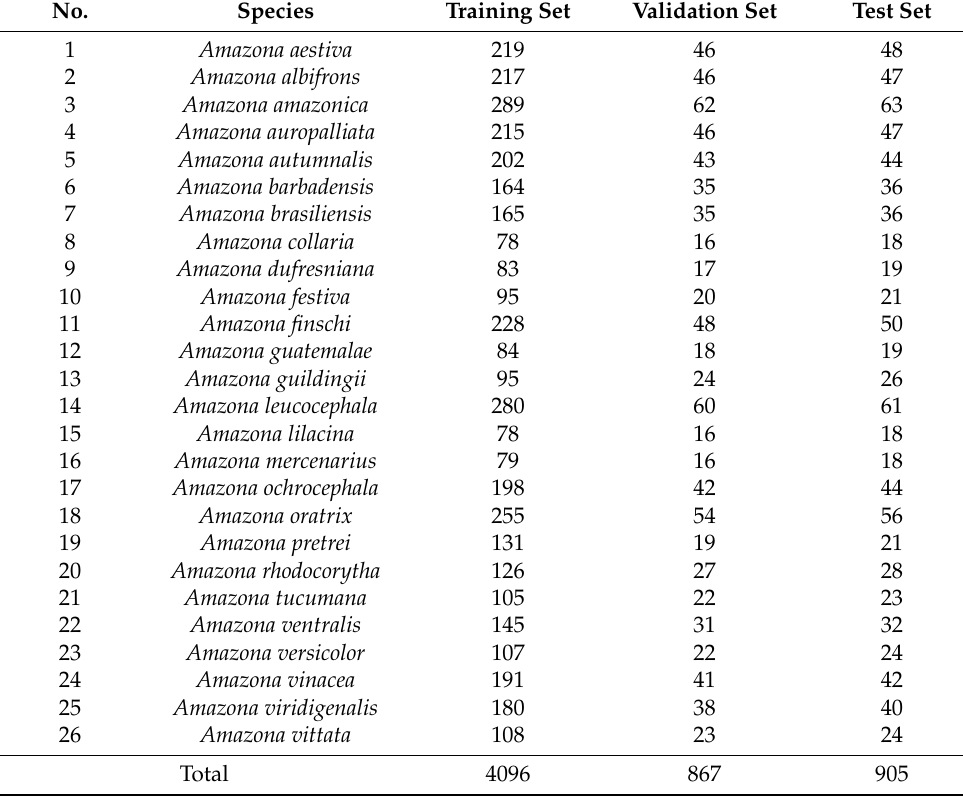
Table 1. Dataset of 26 Amazon parrot species examined in this study. No.